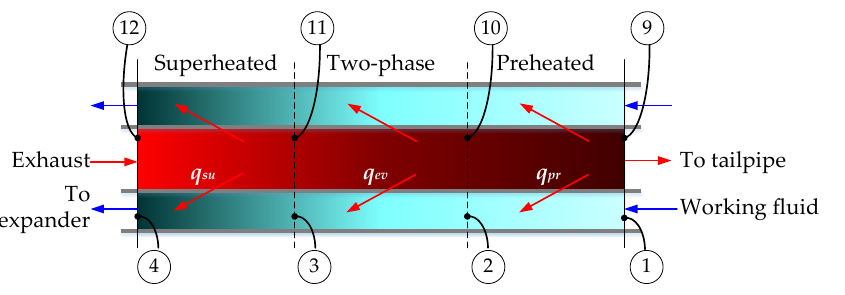
Figure 5. A schematic diagram of the evaporator dynamic model. The thermodynamic properties of the R245fa refrigerant and diesel exhaust gases such as the specific heat and the convection heat transfer coefficient were sourced from an online property calculator developed and maintained by the National Institute of Standards and Technology (NIST) [20]. Thermodynamic properties of the diesel engine exhaust gases were derived from known air and flue mass flow rates and assuming the complete combustion of the fuel having assumed the molecular structure of dodecane (C 12 H 26 ). The cross-sectional area of the evaporator pipe was circular, while the cross-sectional area of the flow channel was rectangular. Considering the convective heat transfer in the tube with different cross-sectional shapes, the Nusselt number Nu of R245fa and exhaust gas was calculated by Equation (2) [41]. The respective heat transfer coefficients h r and h e of R245fa and exhaust gas, the total heat transfer coefficient U of the evaporator, and the heat transfer area A can be calculated from the structural parameters and the LMTD method, as shown in Equations (3)–(5), where the two-phase heat transfer coefficient h ev is determined by Equation (6).